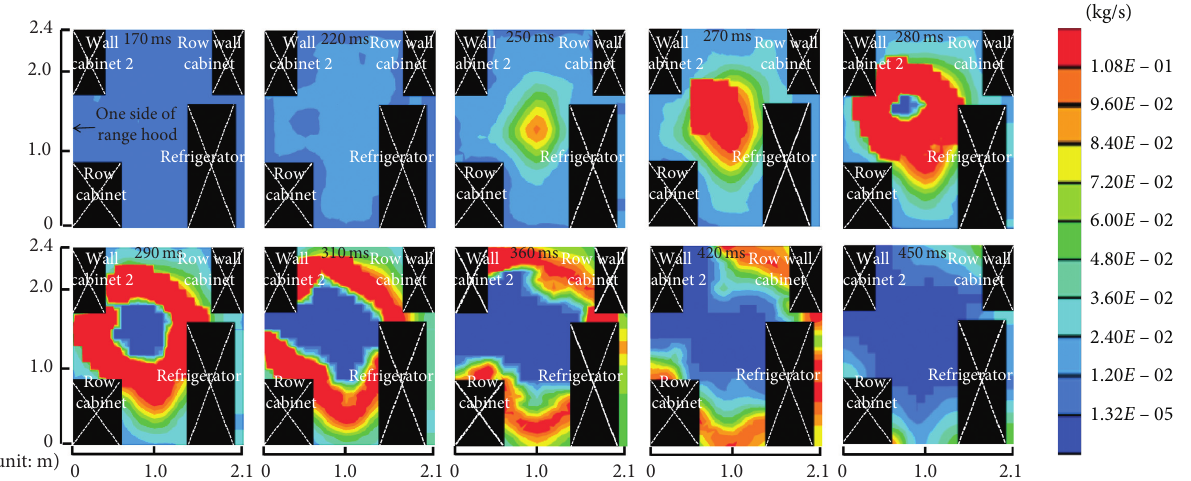
Figure 6: The flame expansion cloud diagram at different moments on the x � 1.7m slice after